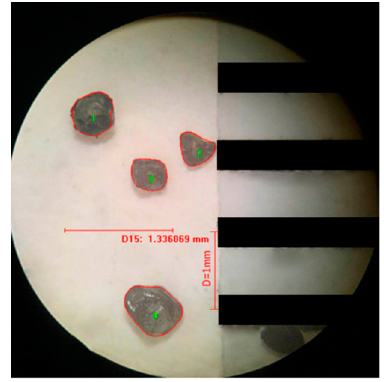
Figure 10. Conversion processing of particle size.